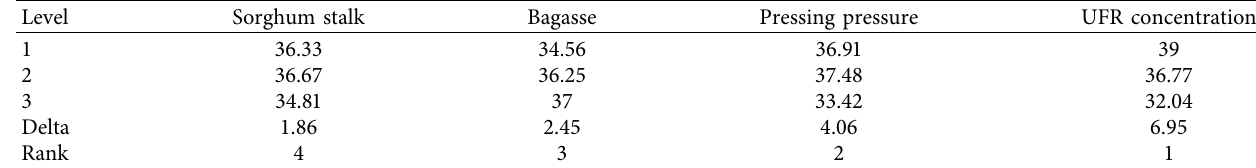
Figure 10: Main Effects Plot for S/N ratio for water absorption. Table 14: Response for effects plot for mean “smaller is better” for thickness swelling.